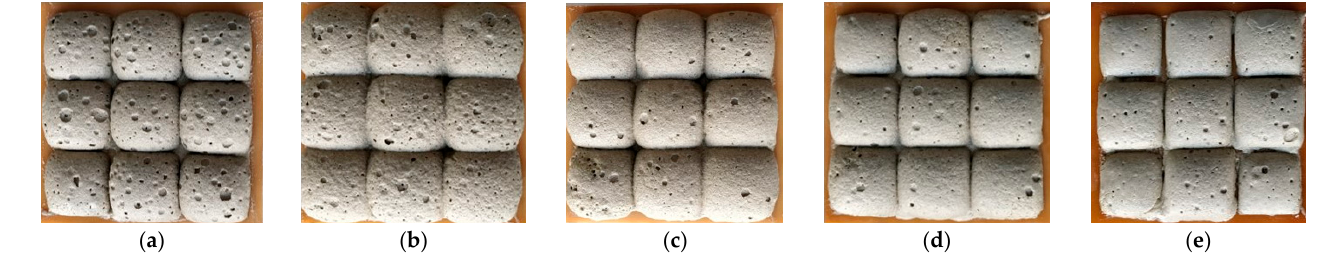
Figure 7. Final foaming and expansion of the specimen mixtures with different phosphogypsum addition: ( a ) P0, ( b ) P3, ( c ) P5, ( d ) P7, ( e ) P10.